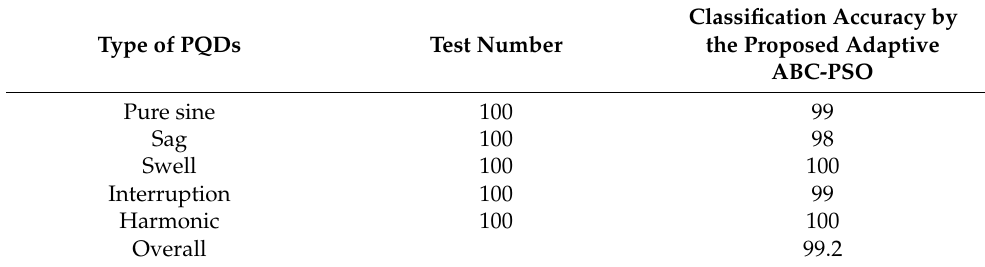
Table 9. Classification accuracy based on a real dataset of a distribution